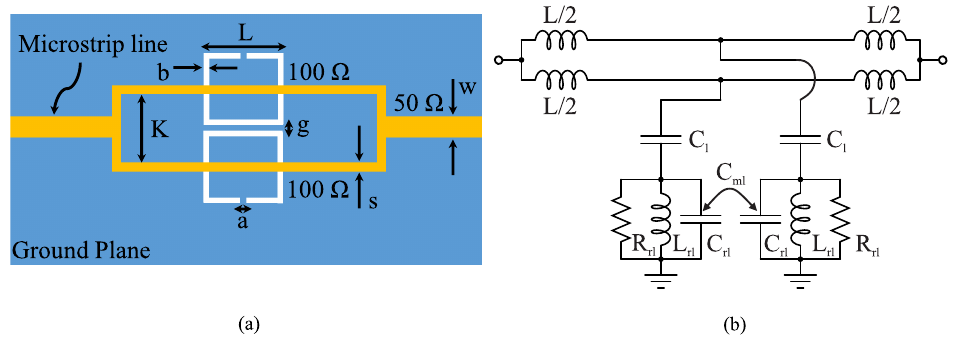
Figure 5. A splitter–combiner microstrip section loaded with two-coupled CSRRs ( a ) footprint ( a = b = g = 0.5 mm, L = 7.5 mm, and K = 7.634 mm) and ( b ) equivalent lumped circuit model. Reprinted with permission from Ref.